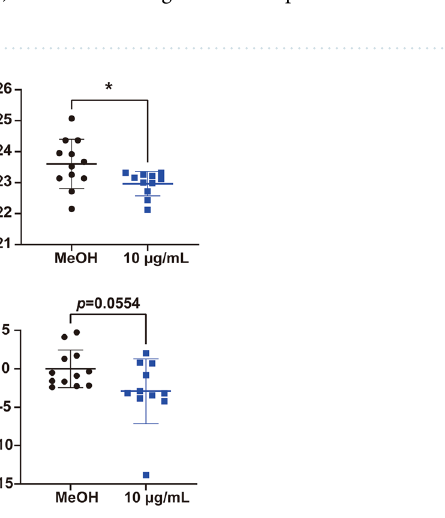
Figure 4. Effects of Allii Chinense Bulbus on locomotor activity rhythms of zebrafish larvae. ( A ) Locomotor activity rhythms under Allii Chinense Bulbus extract (10 µg/mL) and MeOH control. The moving distance (mm) per 10 min were averaged and plotted (n = 11, 12). ( B , C ) Effects on circadian period ( B ) and phase ( C ) are shown. Values are average ± SD and were analyzed by Student’s t-test (n = 11, 12, * p <